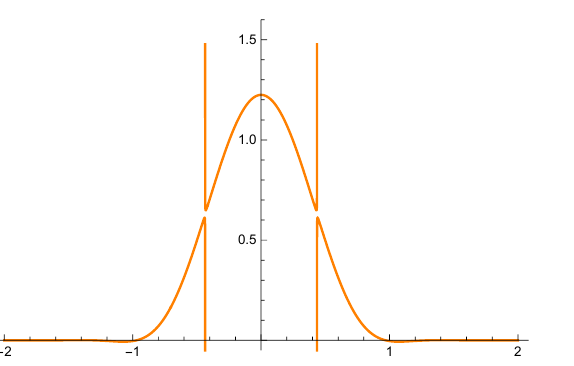
Figure 17. Level n = 0 gauge theory 2-particle Baxter solution q ( (cid:27) ) for ! 1 = 1 p m 0 = (cid:0) ln3 with only one copy of the instanton corrections. 2 (cid:25)